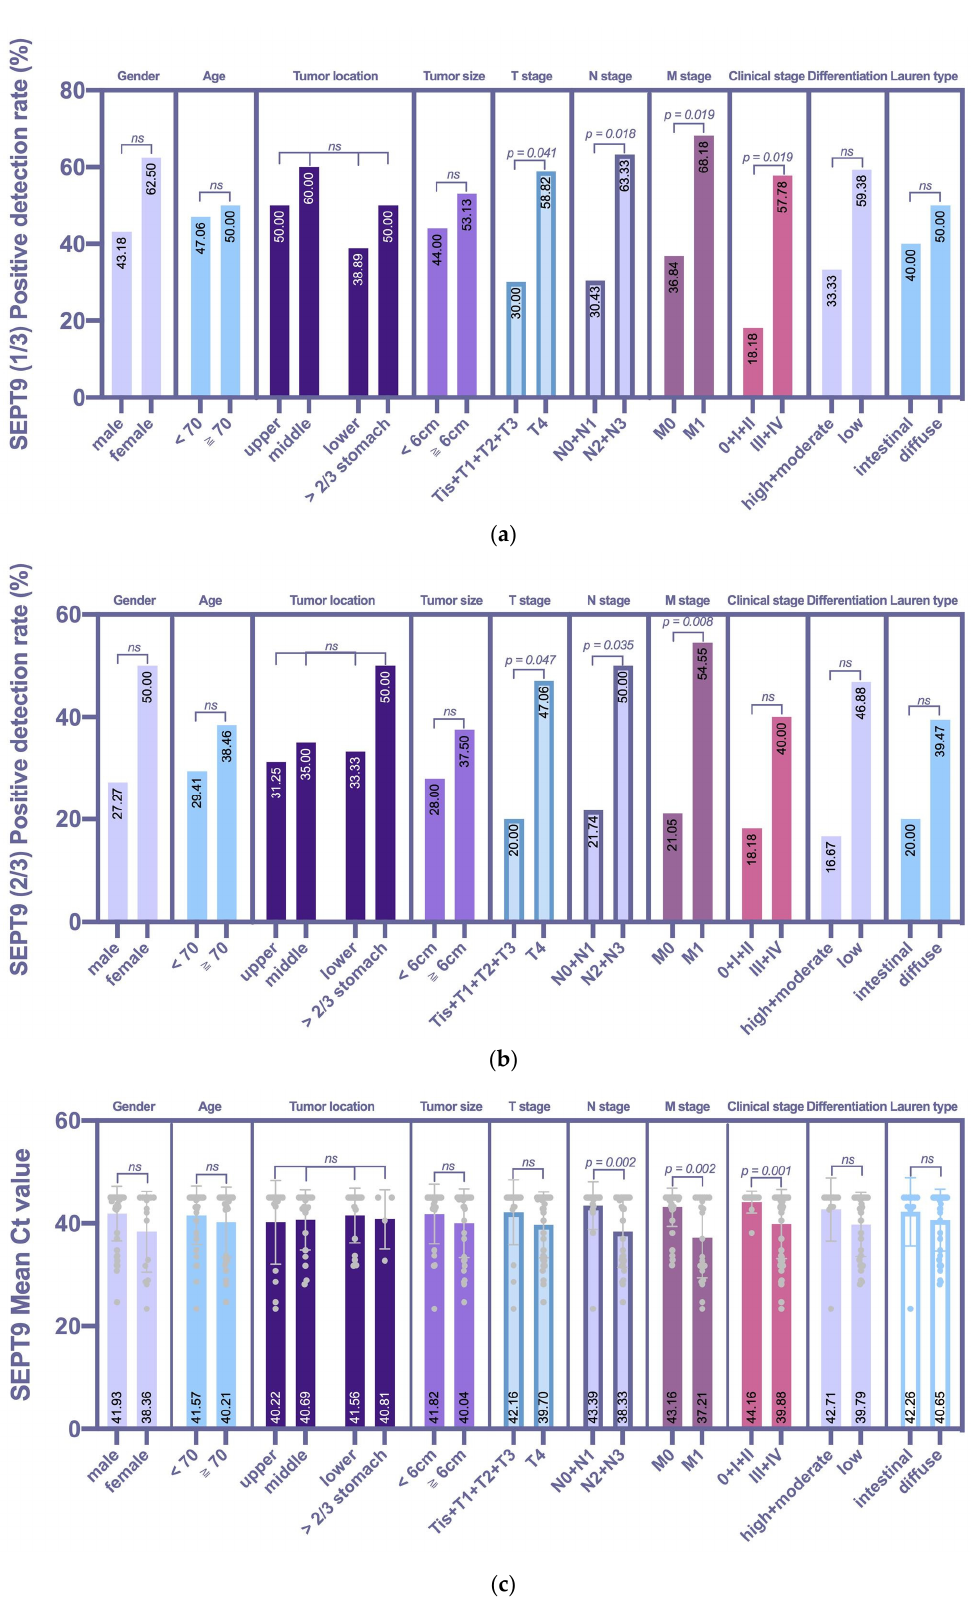
Figure 4. Correlations between mSEPT9 and the clinicopathologic characteristics of the GC group. ( a ) The 1/3 algorithm was compared by the χ 2 test or Fisher’s exact test. GC patients with late T stage ( p = 0.041), N stage ( p = 0.018), M stage ( p = 0.019), and clinical stage ( p = 0.019) showed